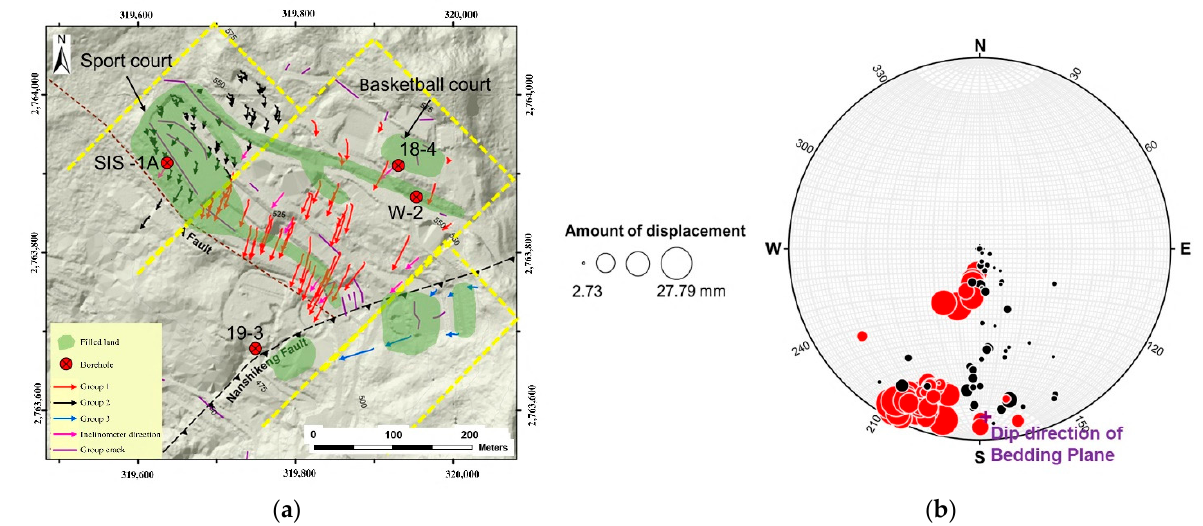
Figure 14. Groups of surficial displacement at the Huafan University campus: ( a ) horizontal dis- placement tracks, revealed by surficial monitoring within the measurement period and the group’s distribution. The displacement vectors represent the movements from the beginning to the end during the measurement period. ( b ) The geometry of displacements, i.e., the displacement vectors presented in a stereonet. The diameter scale shows magnitudes of displacement, and the solid purple cross represents the dip direction of the bedding plane in Zone 2.